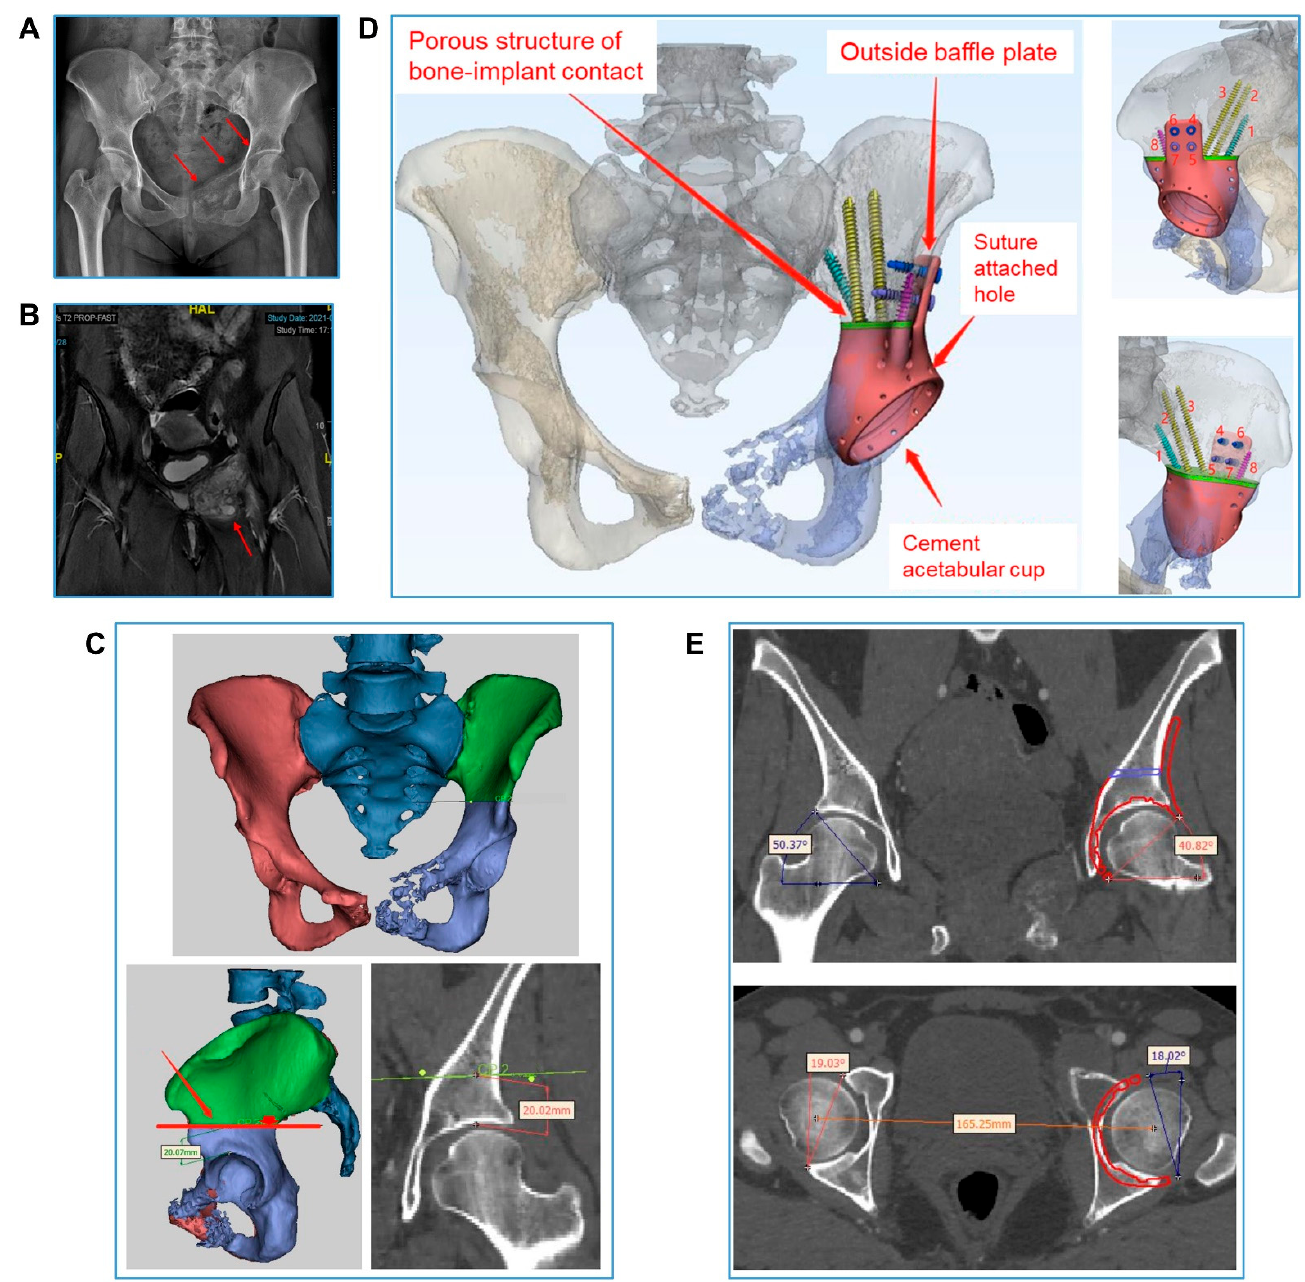
Figure 3. Case 3. Prosthesis design and installation simulation. ( A , B ) Preoperative X-ray and MR displaying the tumor, involving the left acetabulum, the pubis, and the ischium (red arrow). ( C ) Simulation of osteotomy: the osteotomy line is about 20 mm from the upper margin of the acetabulum. ( D ) Design of the 3D-printed hemipelvic endoprosthesis, which is integrative. Between the prosthesis and the autologous bone surface, a porous structure was designed with a size of 3.0 mm mimicking the trabecular bone (green) for the promotion of bone ingrowth and fusion. Screws 1, 2, and 3 are in the iliac force line direction (length, 60 to 80 mm). Screws 4, 5, 6 and 7 are in the lateral direction (length, 20 to 25 mm). Screw 8 is a short spike in the anterior column of the ilium. ( E ) Installation simulation of the 3D-printed acetabular cup: the abduction angle is about 40° and the anteversion angle is about 18°.